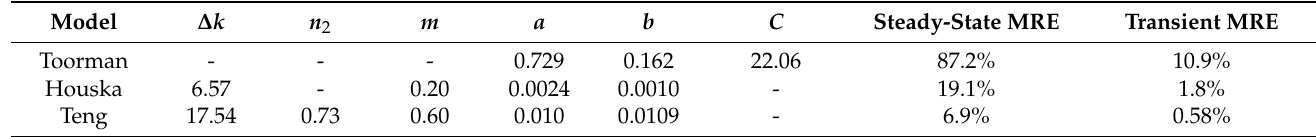
Table 1. Fitted model parameters of the proposed model.